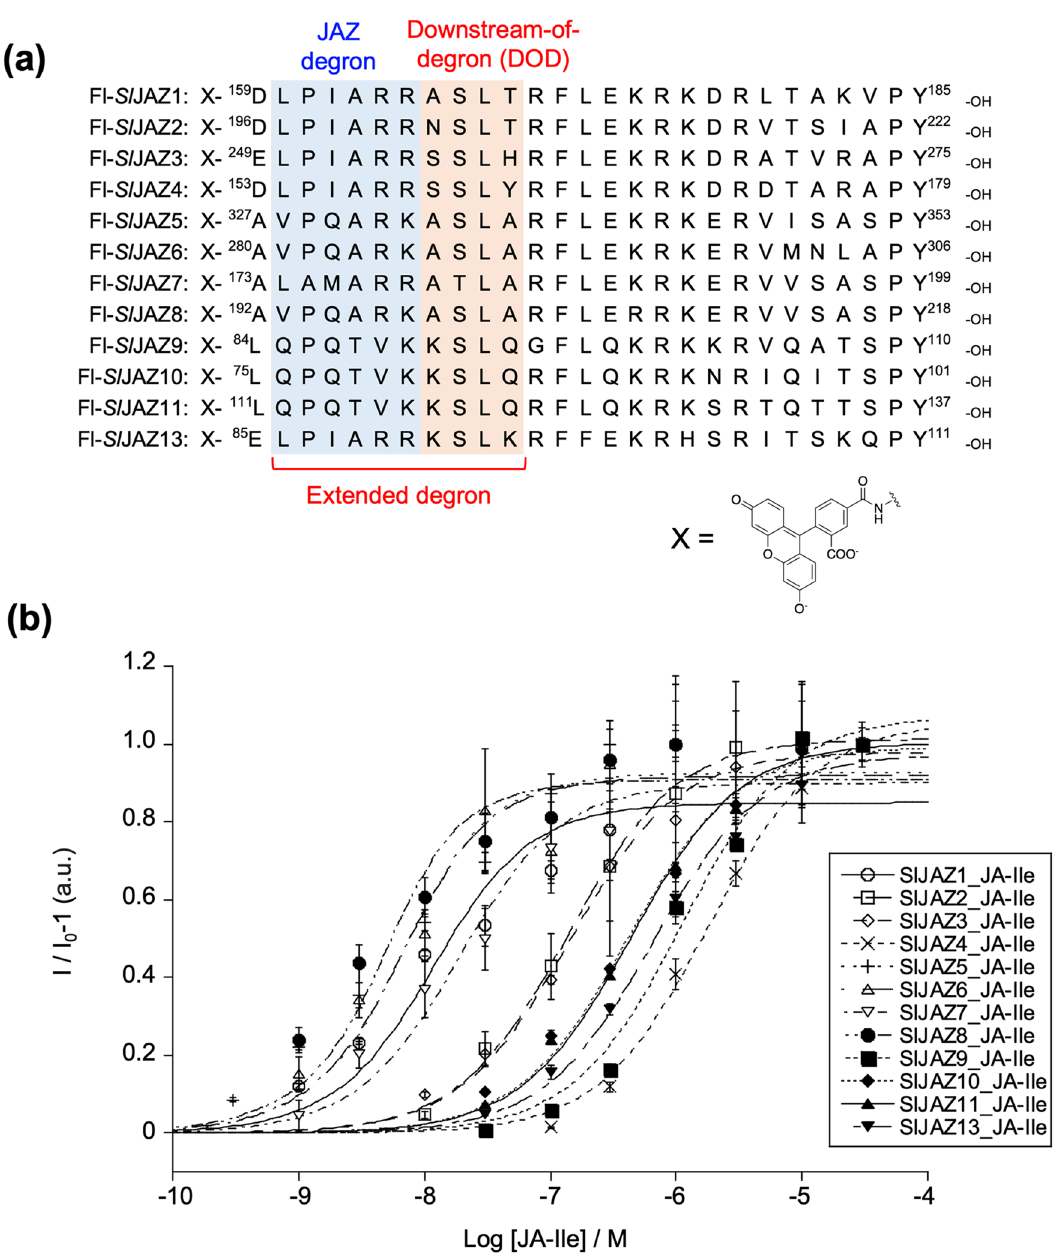
Figure 3. ( a ) Chemical structures of fluorescein-tagged Sl JAZ1-11/13 degron short peptides ( Sl JAZP1-11/13). Canonical JAZ degron sequences are shown in blue and down-stream-of-degron (DOD) sequence are in orange. ( b ) AlphaScreen assays using Fl- Sl JAZPs and GST- Sl COI1 with JA-Ile (0–30 µM). Experiments were performed in triplicate to obtain mean and S.D. (shown as error bars). The figure was created by KaleidaGraph 4.1.1 (Synergy, Software,